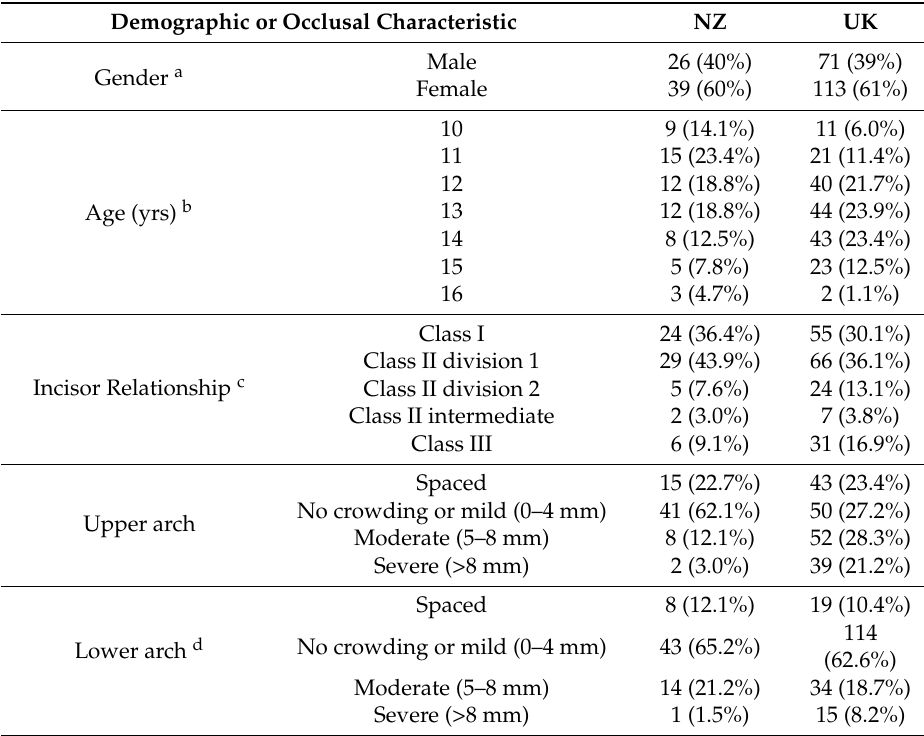
Table 1. Demographics and occlusal data for NZ participants (n = 66) and UK (n = 184). Demographic or Occlusal Characteristic NZ UK